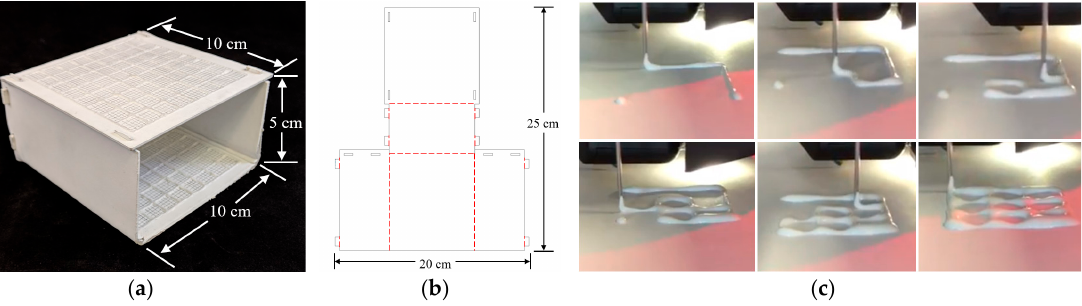
Figure 1. ( a ) Origami lesion targeting device. ( b ) Device folding pattern; solid black lines represent cut lines and dashed red lines represent fold lines. ( c ) 3D printing RCA mixture.